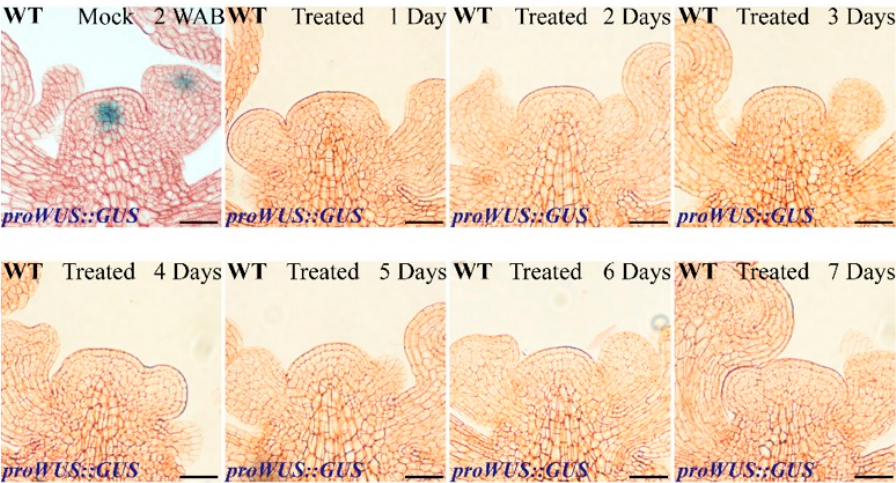
Figure 6 . Effects of exogenous H 2 O 2 on WUS expression. The IMs at 1 WAB were treated with 5 mM H 2 O 2 until 2 WAB. The WUS expression profile from 1 day to 7 days is shown. Scale bars: 20 μ m.